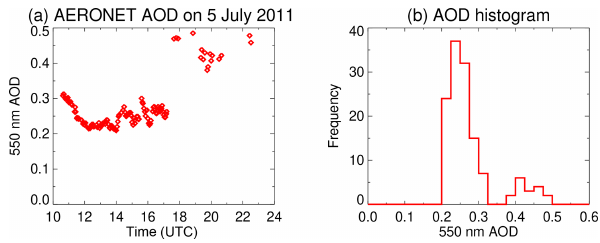
Figure 6. (a) Time series and (b) histogram (bin size 0.025) of 550nm AOD observed at the Essex, Maryland, AERONET site on 5 July